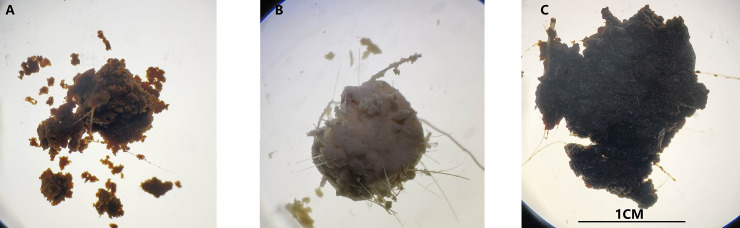
Morphological comparison of different types of musk.(A) Normal musk (NM); (B) white musk (WM); (C) black musk, (BM).